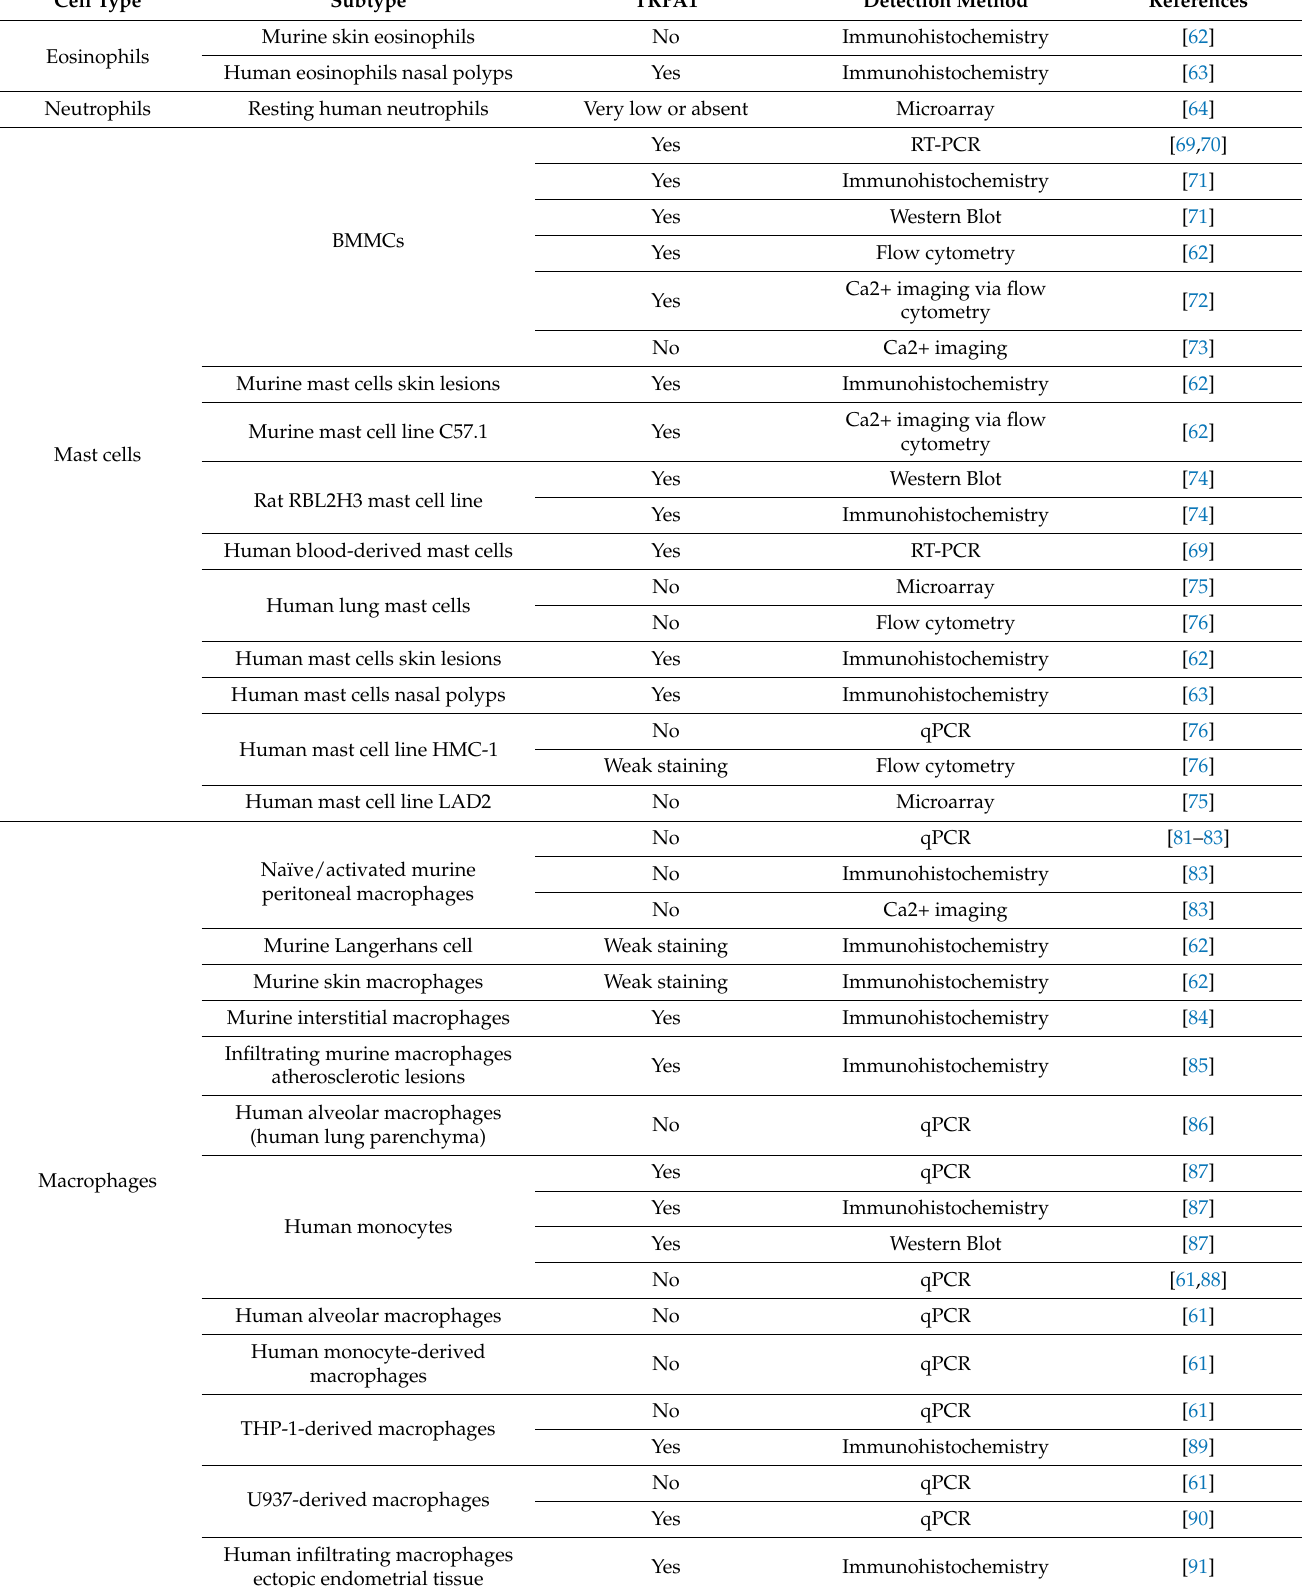
Table 1. Expression of TRPA1 in immune